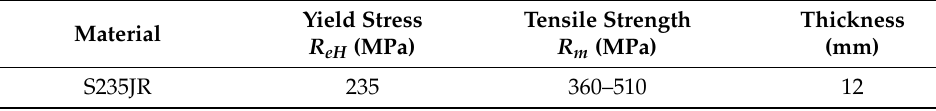
Table 2. Mechanical properties of S235JR steel [6].